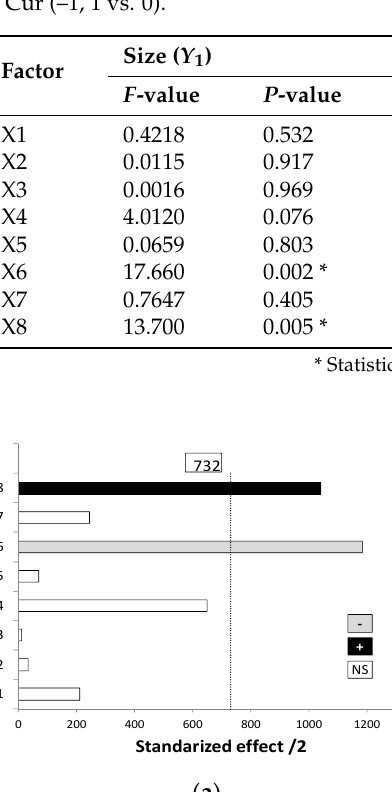
Table 4. Summary of analysis of variance (ANOVA) of experimental results for vesicle size ( Y 1 ), polydispersity index ( Y 2 ), and zeta potential ( Y 3 ). X1: Chems (–1 vs. +1); X2: DDAB (–1 vs. +1); X3: